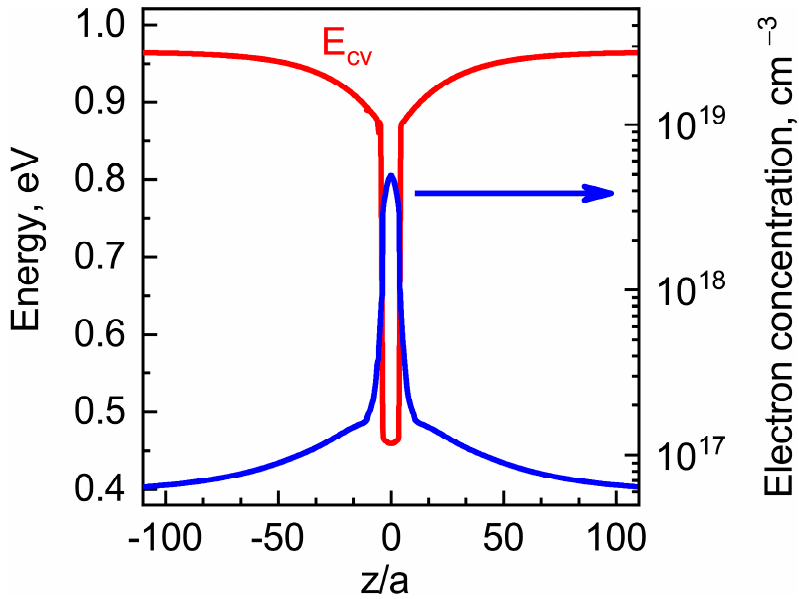
Figure 8. Conduction band energy (shown by red curves, left axis) and electron concentra- tion (shown by blue curves, right axis) calculated in the heterostructure with a QW at T = by blue curves, right axis) calculated in the heterostructure with a QW at T = 1200 1200 K.